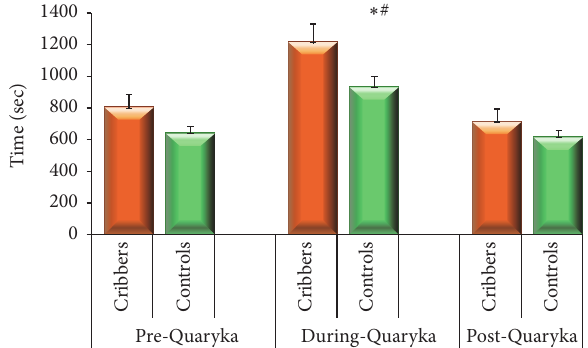
Figure 3: Time needed to finish the concentrate ration in Cribbing and Controls horses during the three phases of the study. ∗ 𝑃 > 0.05 Cribbers versus Controls in During-Quaryka observation period. # 𝑃 > 0.05 Cribbers and Control horses in During-Quaryka versus Pre-Quaryka